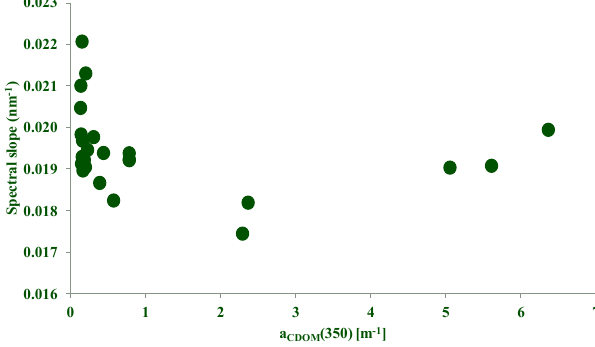
Figure 6. Relationship between a CDOM (350) and the CDOM spectral slope in the Beaufort Sea. 756 757 Fig. 6. Relationship between the CDOM spectral slope and a CDOM (350) in the Beaufort